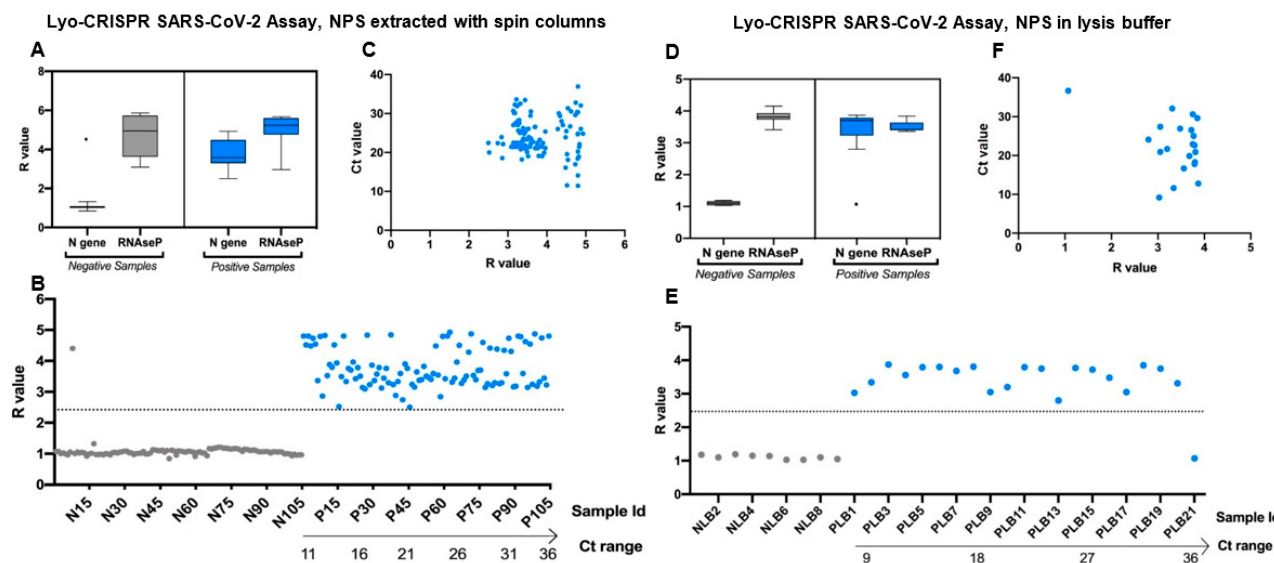
Figure 2. Lyo-CRISPR SARS-CoV-2 kit results of 210 RNA samples extracted from nasopharyngeal swabs (NPS) using spin Figure 2. Lyo ‐ CRISPR SARS ‐ CoV ‐ 2 kit results of 210 RNA samples extracted from nasopharyngeal columns ( A – C ) and 30 RNA samples extracted from nasopharyngeal swabs with direct lysis ( D – F ). ( A , D ) Lyo-CRISPR swabs (NPS) using spin columns ( A – C ) and 30 RNA samples extracted from nasopharyngeal swabs SARS-CoV-2 kit results for N gene and internal control (RNAseP) in RT-qPCR-negative (grey) and -positive (blue) samples. Median, interquartile range, and range of the fluorescence ratio (R = intensity fluorescence (IF) t20 sample/IF t20 non-template control) values measured at 20 min are shown. A positive result was considered if R ≥ 2.5 or negative if R < 2.5. ( B , E ) R values obtained for each RT-qPCR-negative (grey) and -positive (blue) sample tested. Each dot represents one sample and the dashed line represents the cutoff of the Lyo-CRISPR test to classify them. Positive samples were sorted by Ct values determined using the GeneFinder RT-qPCR kit (N gene). ( C , F ) R values obtained for each RT-qPCR-positive sample tested. Each dot represents one sample. N: nucleocapsid; Id: identification; Ct: Cycle threshold, R: fluorescence ratio. Figures were designed with GraphPad Prism V8 software (GraphPad, San Diego, California, USA) and